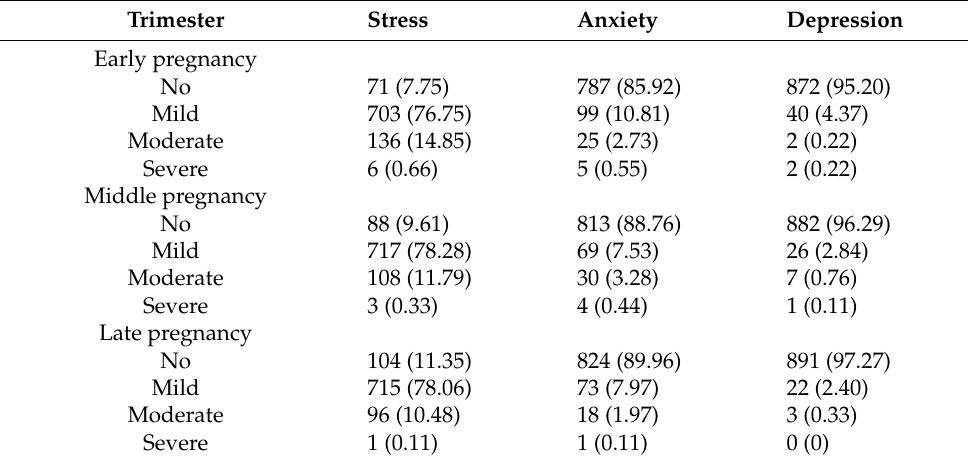
Table 1. Prevalence of stress, anxiety and depressive symptoms (n (%)).